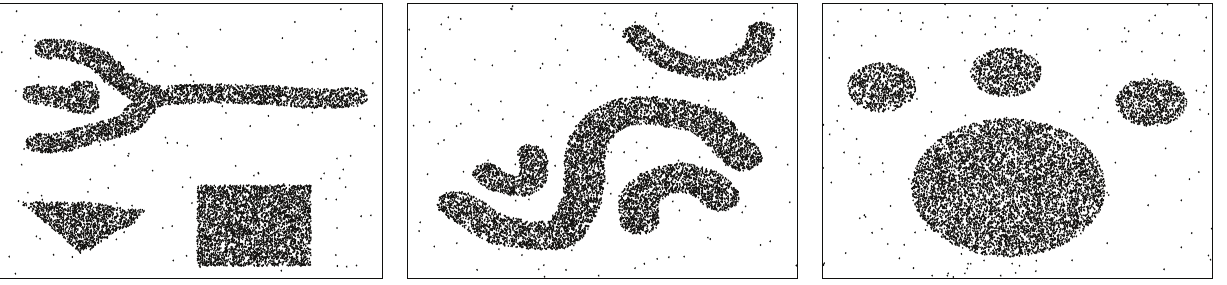
Figure 4: Synthetic datasets.